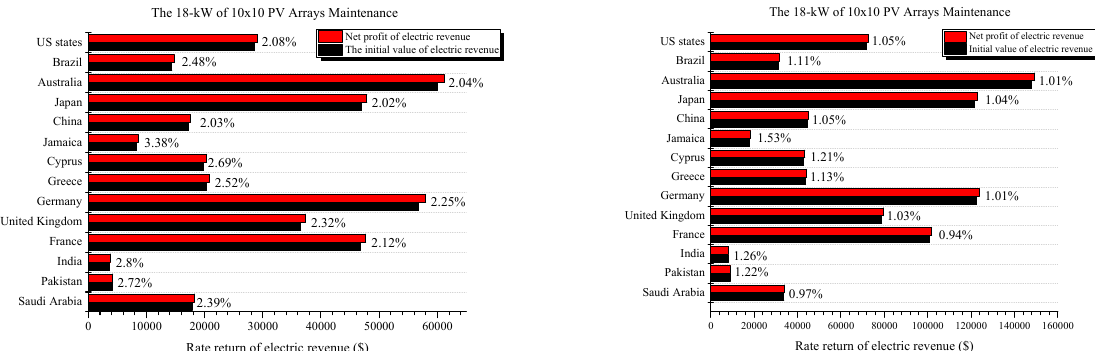
Figure 11. The increase in rate returns of electric revenue associated with the two types of 10 × 10 PV arrays, taking into account the greatest annual economic advantage.